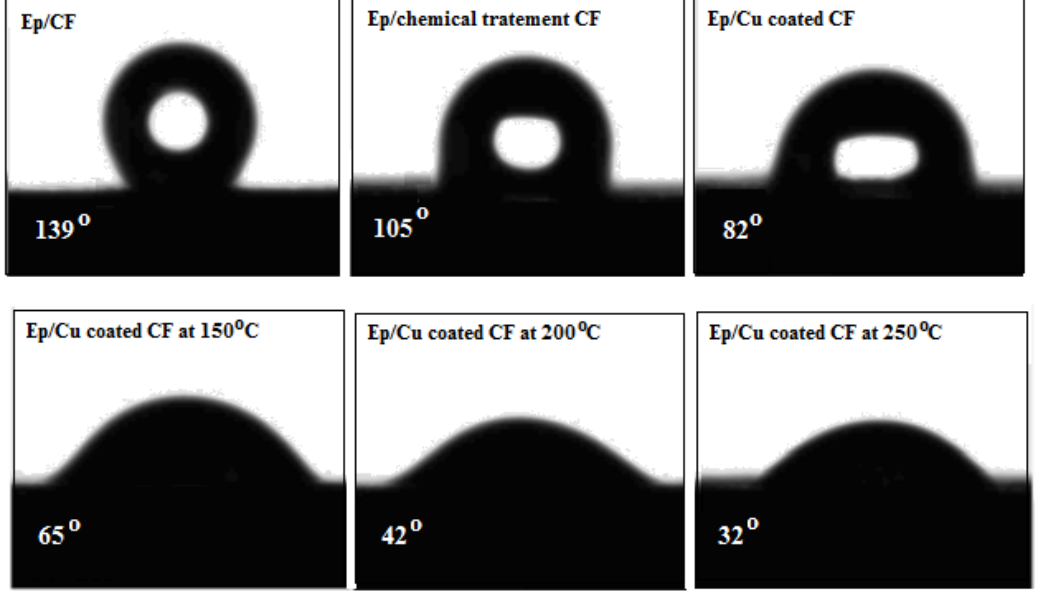
Fig. 5: Contact angle of Ep/CF, Ep/chemical treated CF and Ep/Cu coated CF composites at a different treatment temperatures (150, 200, 250) o